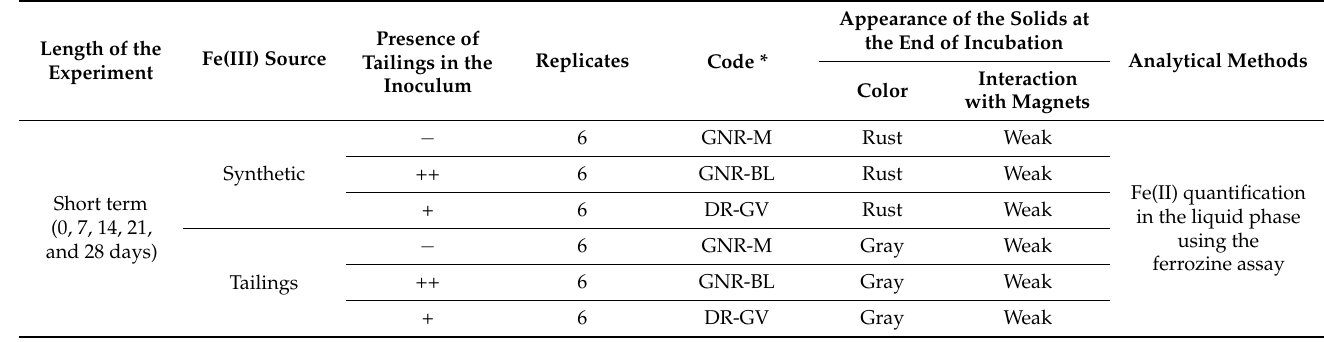
Table 1. Summary of the experiments. Codes in italic represent samples that changed significantly at the end of the experiment and were further characterized by XRD, transmission electron microscopy, and magnetic property analyses. Presence of Length of the Fe(III) Source Replicates Code * Tailings in the Experiment Inoculum